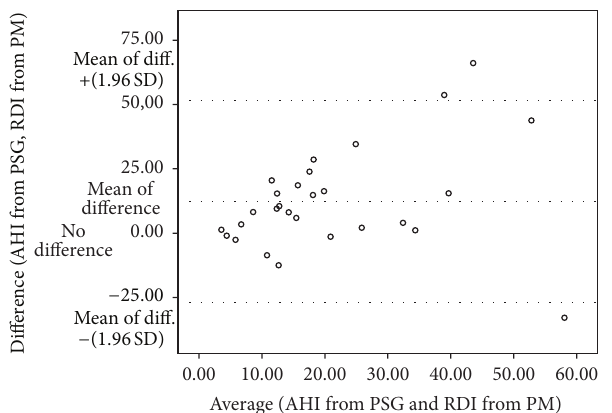
Figure 3: Bland-Altman plot comparing AHI from PSG and RDI from